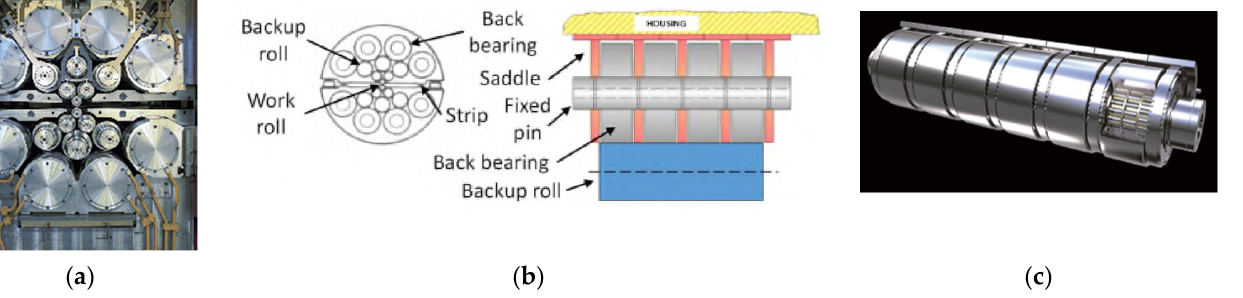
Figure 4. Layout of cluster mill with inner fixed pin: picture ( a ) [60], sketch ( b ), and rendering ( c ) [61].